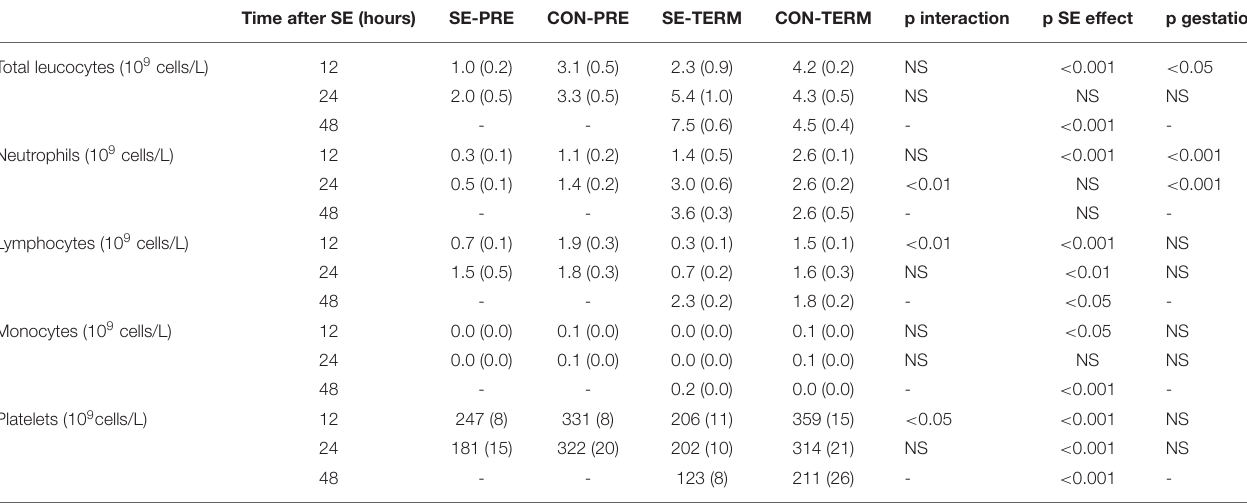
TABLE 3 | Hematological parameters in Experiment 1 . Time after SE (hours) SE-PRE CON-PRE